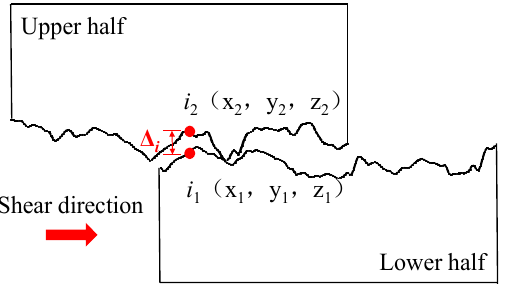
Figure 11. Polar charts of the roughness coefficient, JRC , and the calculated JRC values for contour lines in different directions (shear displacement = 25 mm) for fluctuation angles of ( a ) 15°, ( b ) 30° and ( c ) 45°.